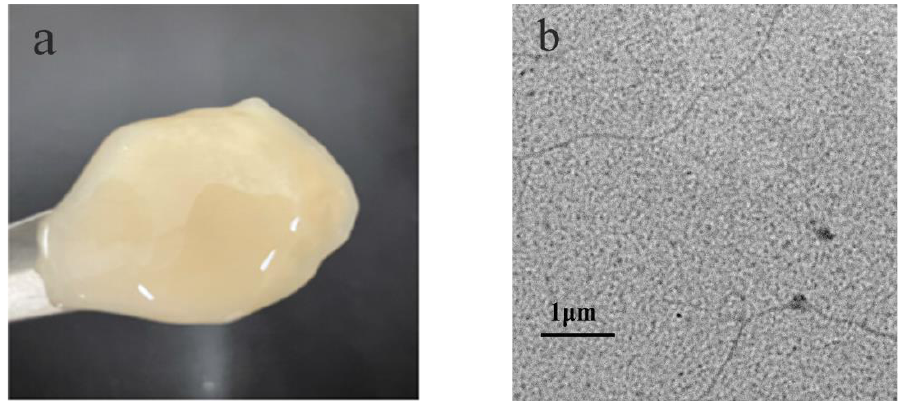
Figure 1. ( a ) Photo of TEMPO-oxidized cellulose jelly from the treated WS powder; ( b ) TEM image of